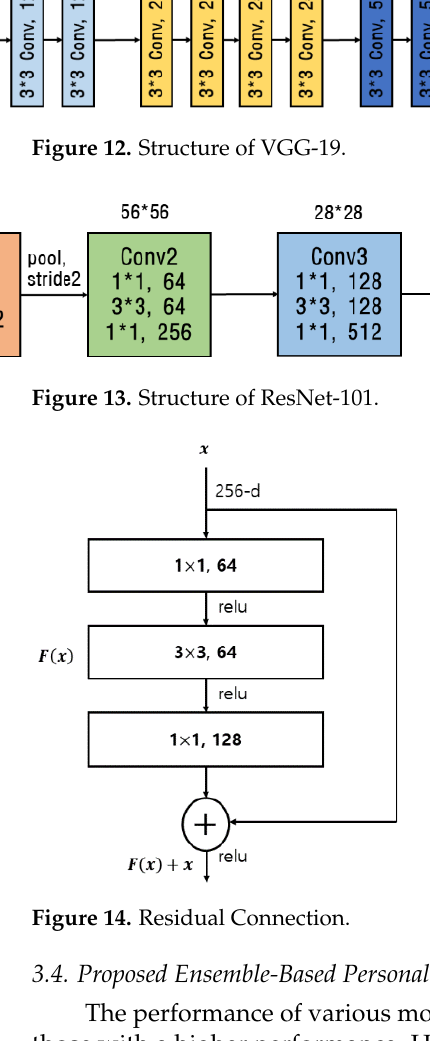
Figure 15. Flowchart of proposed ensemble-based personal identification. In the first step of signal preprocessing, noises need to be removed for maintaining the shape of ECG signals. This is because the signals can be distorted by various noises during measurement. In an ECG, breathing, friction between skin and electrode, noise